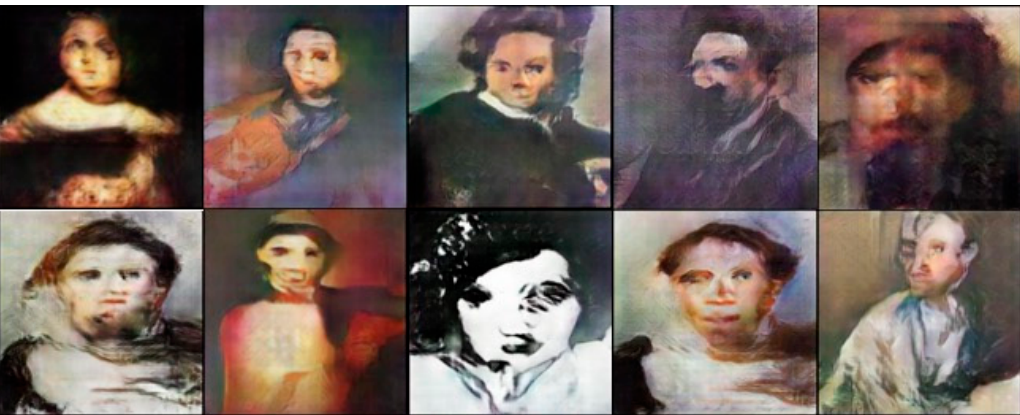
Figure 2. Examples of images generated by training a generative adversarial network (GAN) with portraits from the last 500 years of Western art. The distorted faces are the algorithm’s attempts to imitate those inputs. Images generated at Art & Artificial Intelligence Laboratory, Rutgers.